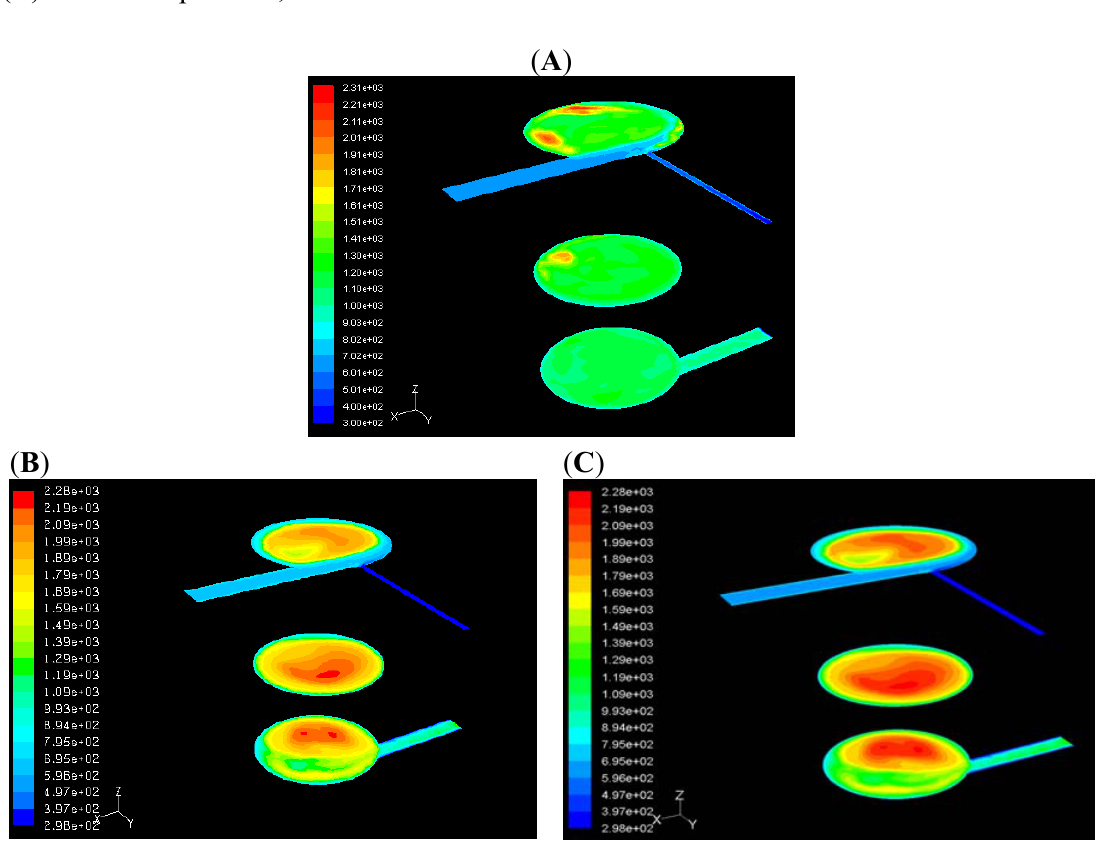
Figure 3. (A) Flamelet: Temperature, t = 0.03s; (B) EDC: Temperature, t = 0.03